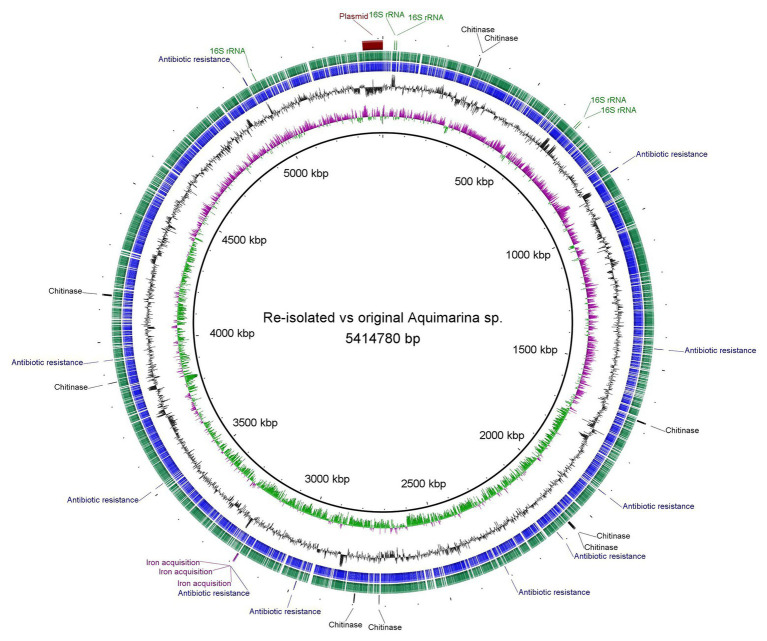
Circular representation and Basic Local Alignment Search Tool (BLAST) comparison of the isolated Aquimarina sp. genomes analysed and generated using BLAST Ring Image Generator (BRIG). Circular tracks display (from the inside): (1) GC skew, (2) GC plot, (3) coding sequences of original Aquimarina sp. TRL1, (4) coding sequences of reisolated Aquimarina sp., and (5) encoded genes (16S rRNA, chitinase, antibiotic resistance and iron acquisition) in the chromosome and the plasmid region.